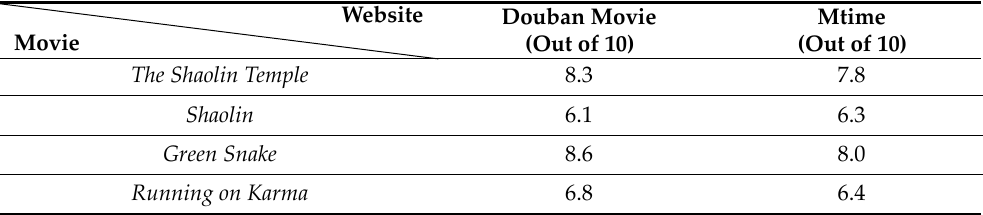
Table 1. Site ratings for four Buddhist movies 4